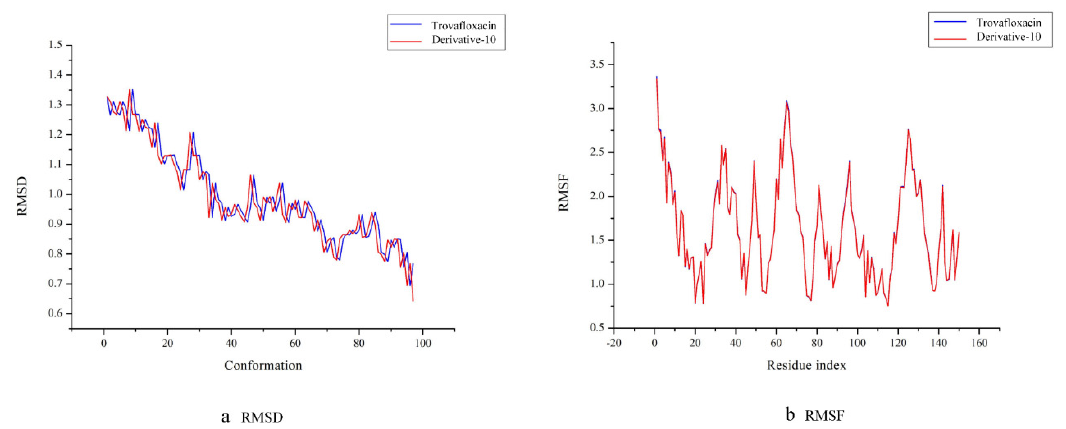
Figure 6. RMSD and RMSF curves of trovafloxacin and derivative-10 binding to plasma protein. ( a ): RMSD; ( b ): RMSF.